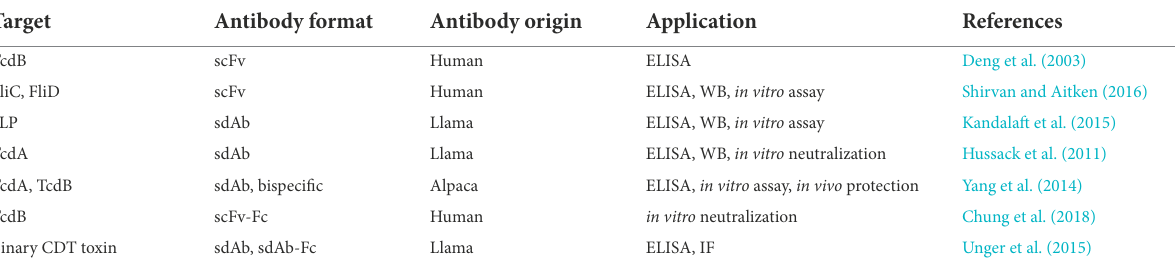
TABLE 3 Recombinant antibodies derived from phage display libraries against Clostridioides difficile .